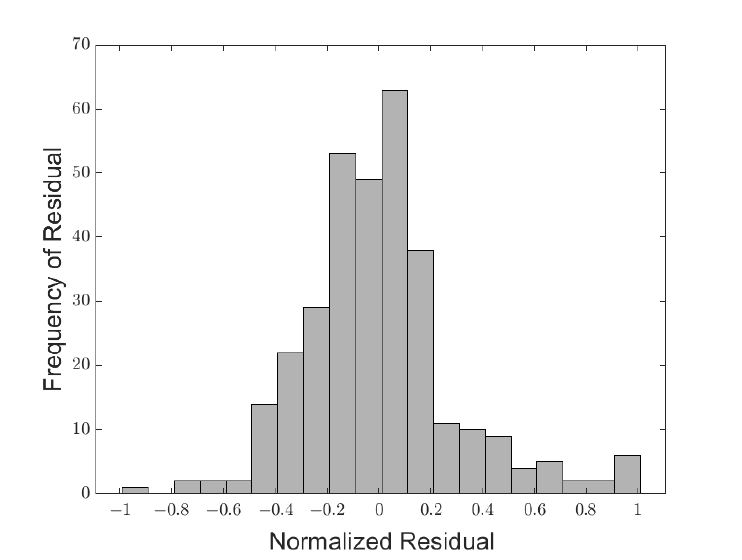
Figure 11. Histogram of normalized